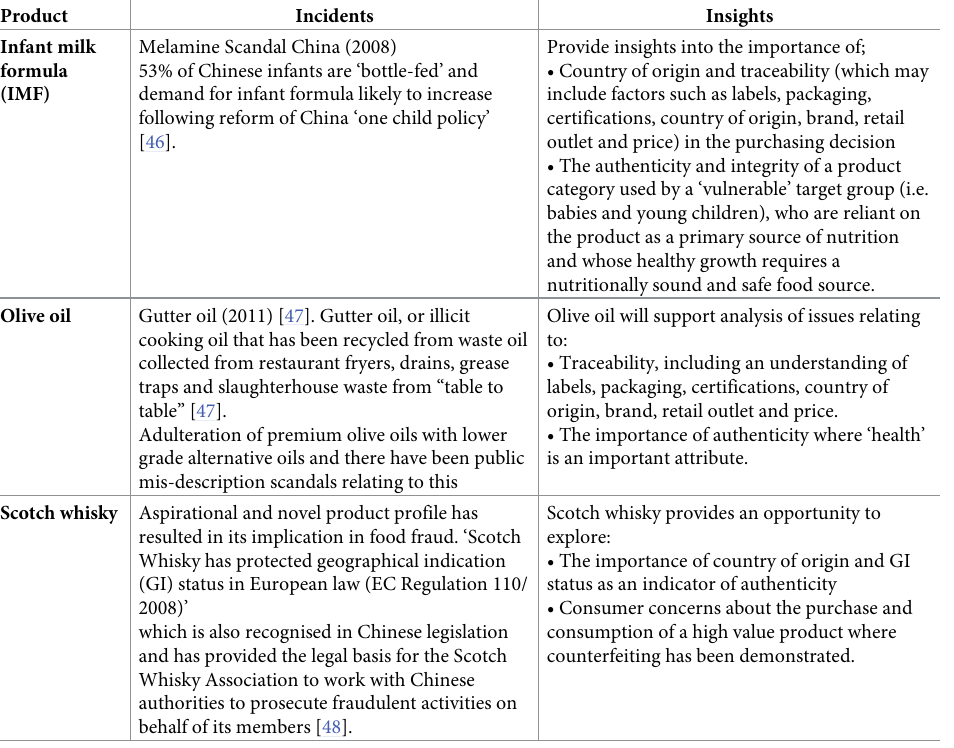
Table 2. European food and drink product research